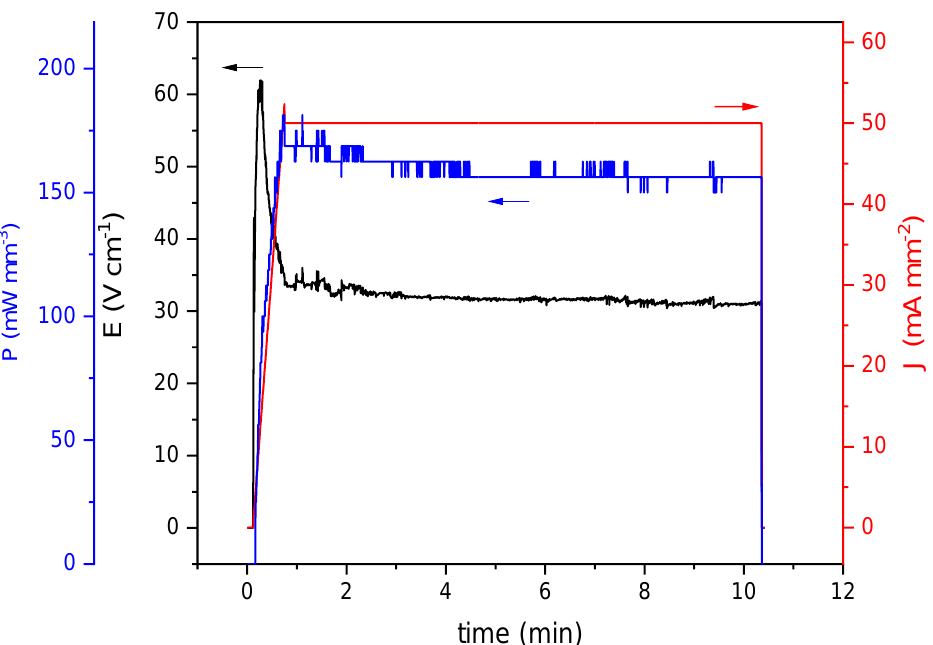
Figure 1. Evolution of reaction flash parameters, electric field, power density dissipation, and current density limit, as a function of time during the reactive flash process.